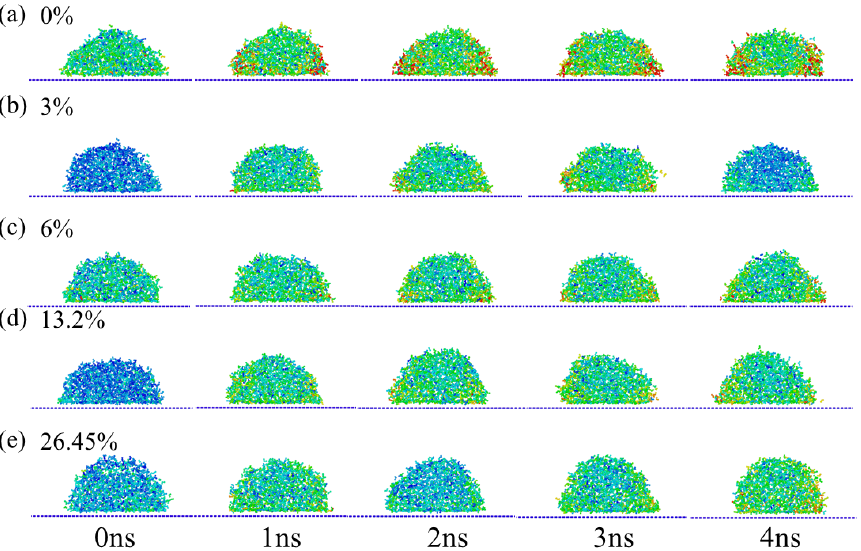
Figure 2. Distribution of molecules under different concentration of NaCl. ( a ) 0%, ( b ) 3%, ( c ) 6%, ( d ) 13.2%, ( e ) 26.45%.